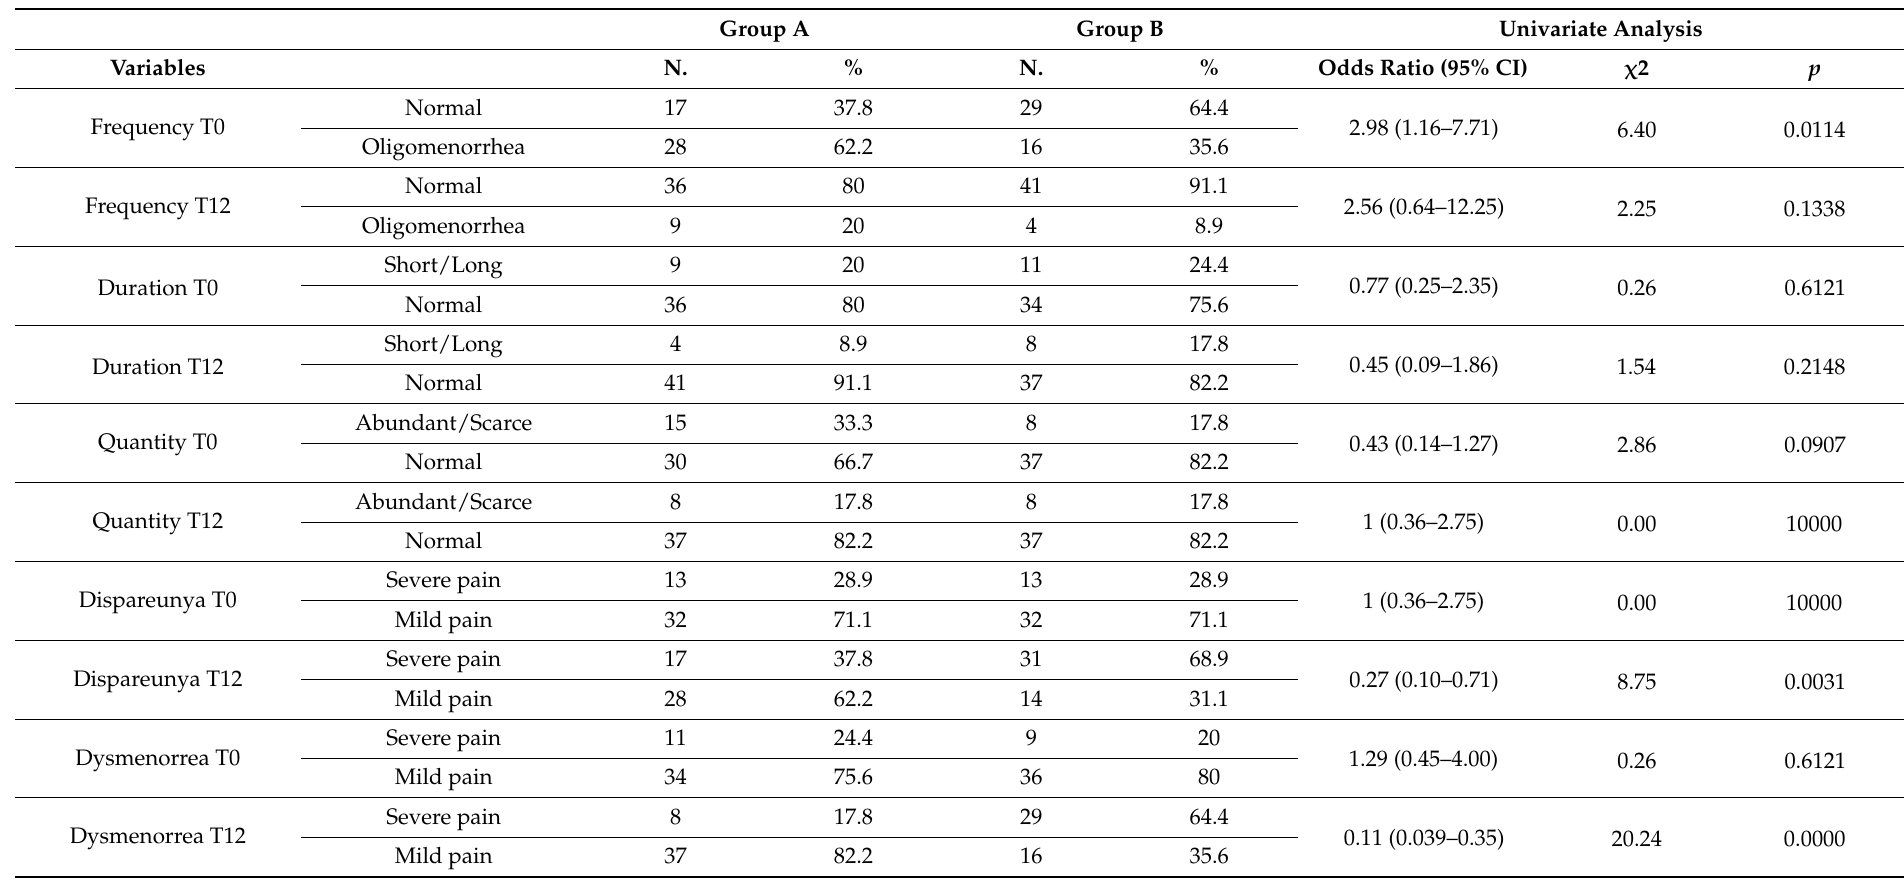
Table 4. Inter-group comparison of menstrual frequency, duration of the cycle, the amount of the menstrual cycle, dysmenorrhea, and dyspareunia in long-term survivors of lymphoma at baseline (T0) and after 12 months